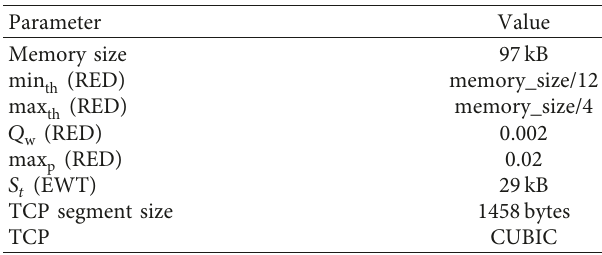
Table 3: Simulation parameters.